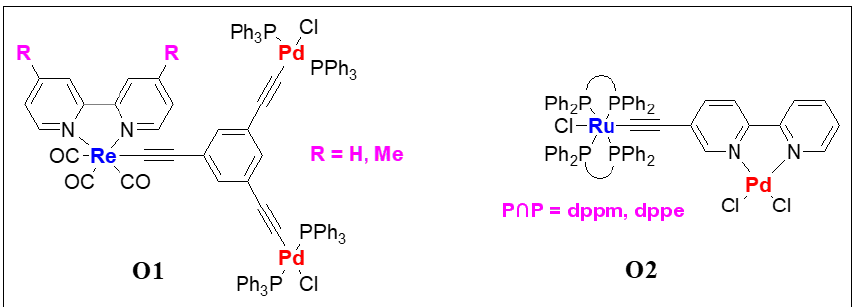
Figure 6. Re(I)/Pd(II) hetero-trimetallic ( O1 ) and Ru(II)/Pd(II) heterometallic ( O2 ) complexes. Piazza and coworkers [52] assessed the photo-physical and magnetic properties of Ru(II)/Cu(I) and Ru(II)/Mn(I) couples O3 and O4 (Figure 7). Interestingly, a long-distance magnetic coupling between the terminal Cu(II) units through Ru(II) fragment was noted. Moreover, heterometallic systems displayed low energy bands in the visible region (Table 2). Cu(II) complexes exhibit higher thermal stability compared to Mn(I) complexes.